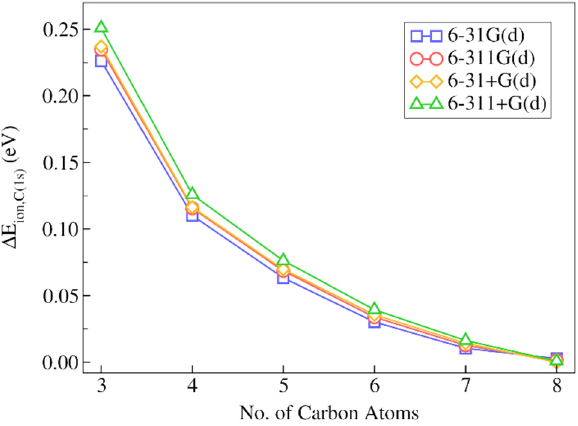
Figure 5. Absolute deviations of the IMOM/ELMO 1s core-ionization energies for the terminal carbon atom of decane from the reference fully IMOM values ( ∆ E ion,C ( 1s ) ), as a function of the number of carbon atoms gradually included in the quantum mechanical region of the QM/ELMO calculations. Only the results of the computations performed with the PBE0 functional are reported. Table 1. Relative discrepancies (in %) of the IMOM/ELMO 1s core-ionization energies for the terminal carbon atom of decane with respect to the reference fully IMOM values, as a function of the number of carbon atoms progressively included in the quantum mechanical subsystem of the performed QM/ELMO computations. Only the results of the calculations performed with the PBE0 functional are